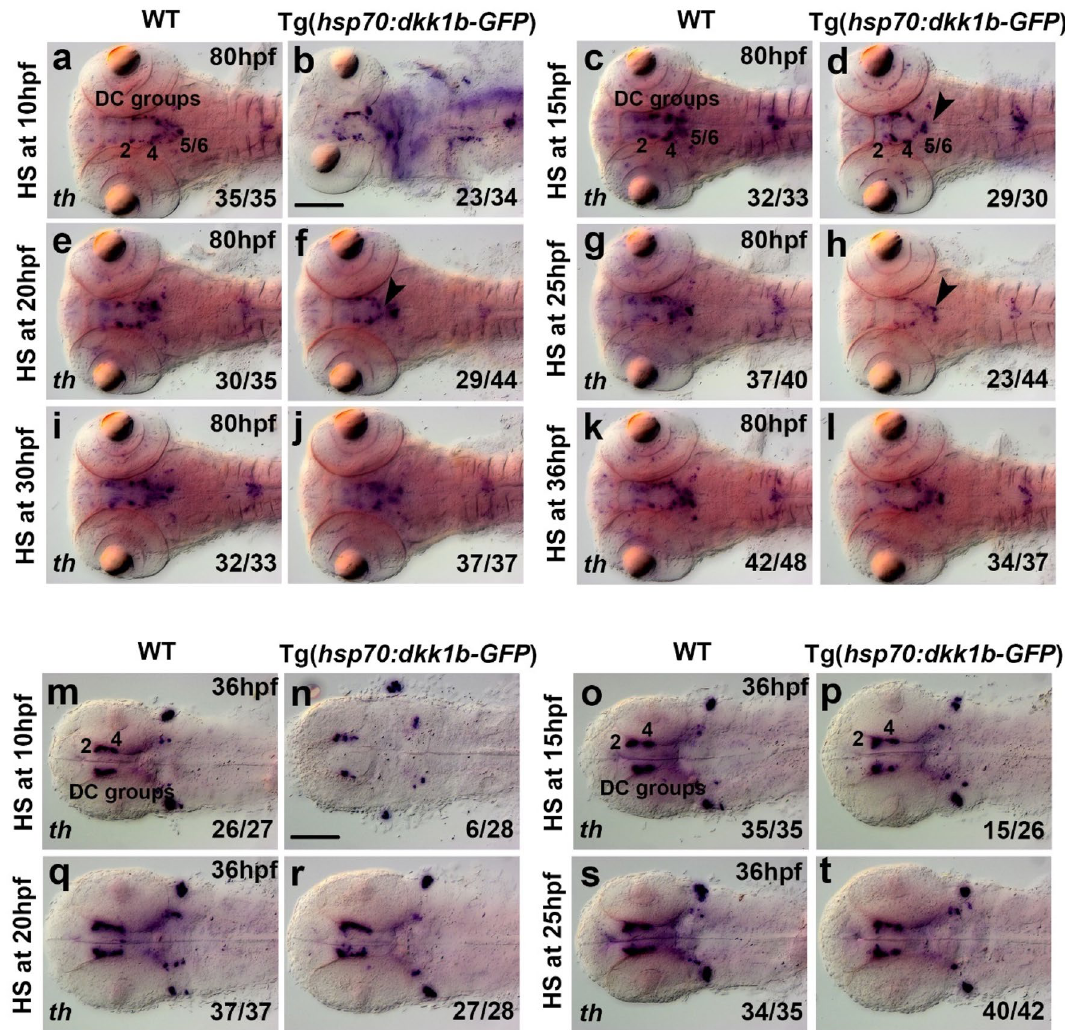
Figure 7. Heat shock induced Dkk1b overexpression affects hypothalamic DC5 and DC6 DA neurons in a stage dependent manner. ( a – s ) Expression of DA neuron marker th as detected by WISH in WT embryos and heterozygous transgenic Tg( hsp70l:dkk1b-GFP ) siblings after heat-shock treatment as indicated on the left side of each pair of images, and subsequently fixed at 80 hpf ( a – l ) or 36 hpf ( m – t ). Dorsal views, images are Z-projections of image stacks. The arrowheads in ( d ), ( f ) and ( h ) point at a decrease in th expression in DC5 and DC6 DA neuron groups. Scale bars in ( b ) for ( a – l ) and in ( n ) for ( m – t ) are 100 µm. Numbers N/N in bottom right corner of each image indicate number of representative phenotypes as shown in image versus total embryos analyzed for this